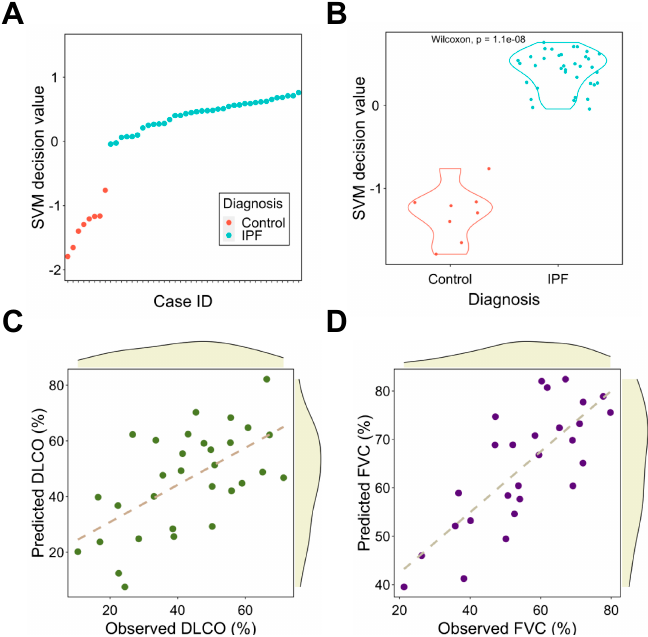
Figure 5. Signature as a diagnosis and assessment tool for pulmonary fibrosis using machine learning models. ( A ) The SVM scores for IPF patients and healthy controls. ( B ) Comparison of SVM decision value between IPF patients and healthy controls. ( C , D ) Correlation analysis between observed and predicted DLCO ( C ) and FVC ( D ). The dashed line represents the linear regression line. DLCO: diffusing capacity for carbon monoxide; FVC: forced vital capacity; IPF: idiopathic pulmonary fibrosis; SVM: support vector machine.